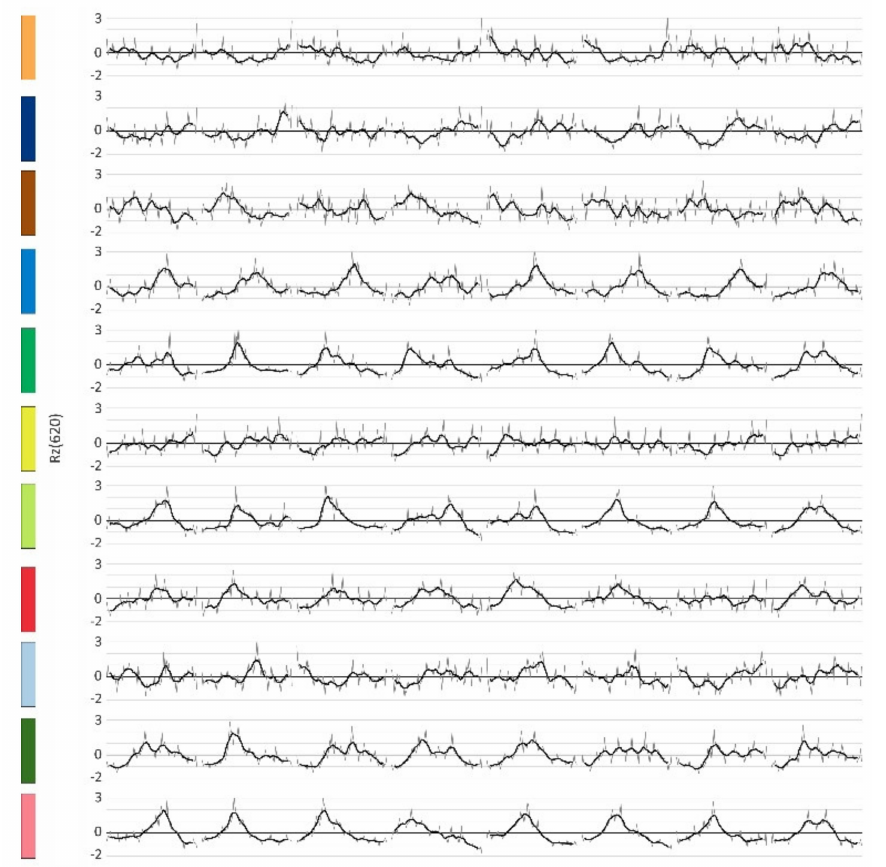
Figure 10. The R z (620) prototypes of the clusters, with the colors from the image “C1–C11”. A moving average of ten days was used for a clearer